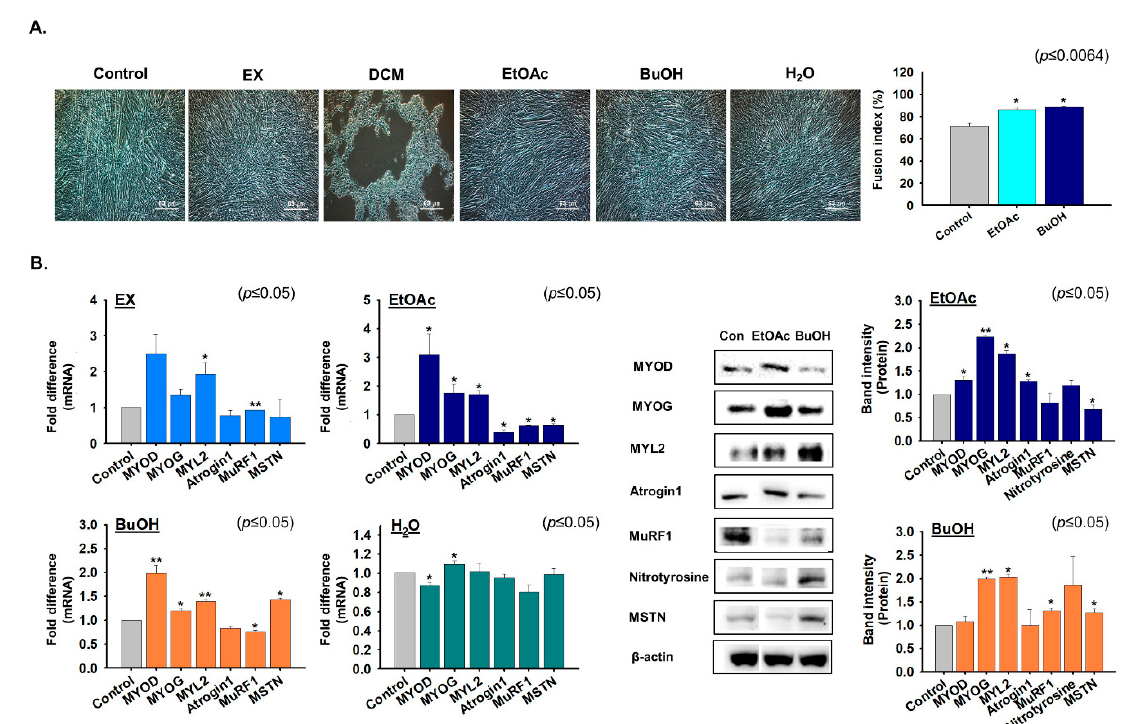
Figure 4. Cell differentiation in the presence of the five fractions of G. uralensis CWE. When C2C12 cells have researched 100% confluency, cells were incubated in differentiation media supplemented with 25 µg/mL of each of the five G. uralensis fractions (EX, DCM, EtOAc, BuOH, or H 2 O) for four days. ( A ) Myotube formation and fusion indices were assessed by Giemsa staining. ( B ) mRNA expression as determined by real time RT-PCR and protein expression by Western blot. Non-treated cells were used as controls. Means ± SD ( n = 3). * p ≤ 0.05, ** p ≤ 0.001.